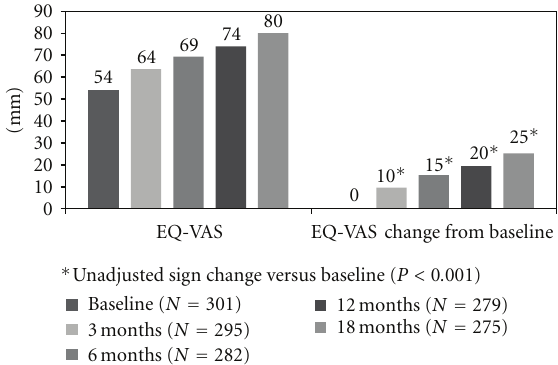
Figure 7: EQ-5D as defined by patients through the visual analog scale tool (mm) and EQ-5D VAS change from baseline